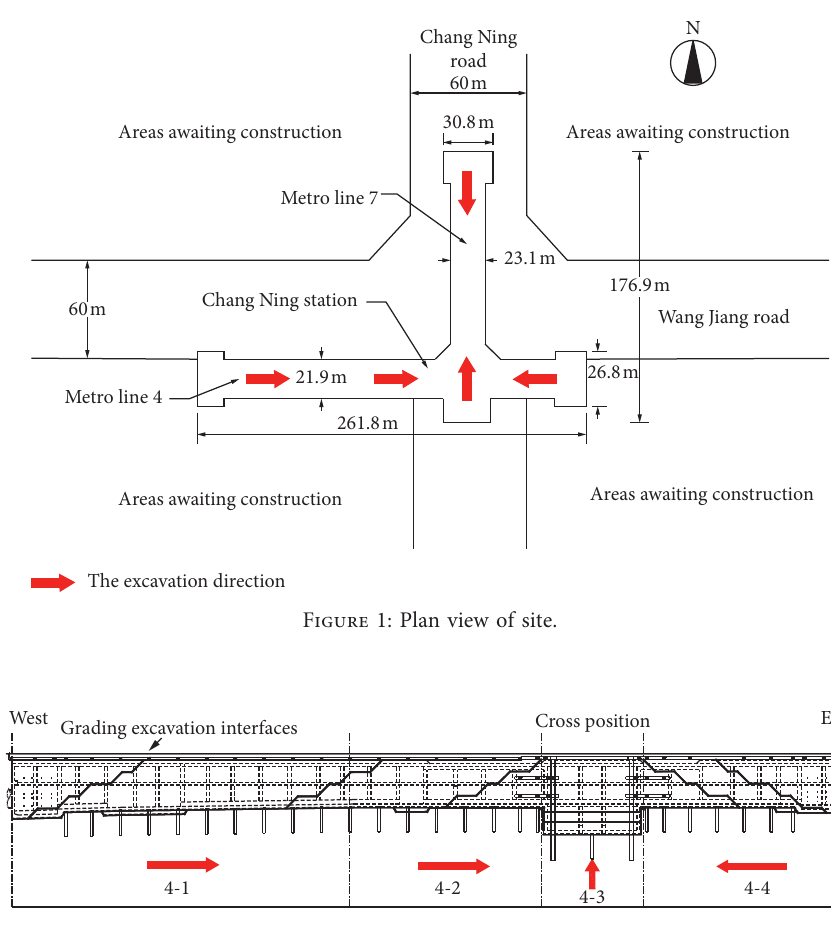
Figure 2: The profile of the excavation sequence.